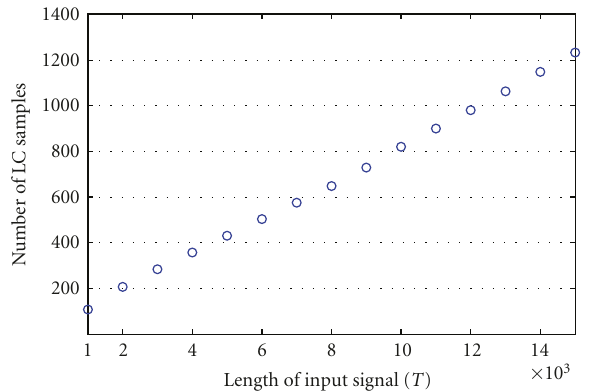
Figure 8: The number of LC samples used to obtain the perfor- mance in Figure